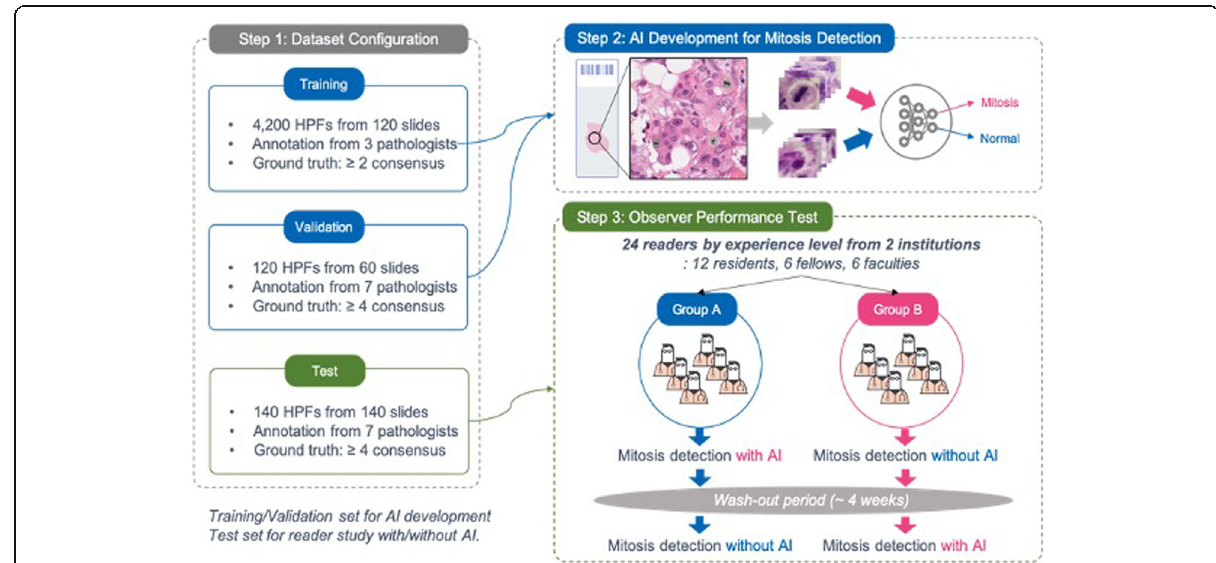
Fig. 1 Flow chart of the methodology and datasets employed in developing and validating an AI-based tool to quantify mitoses in breast carcinoma